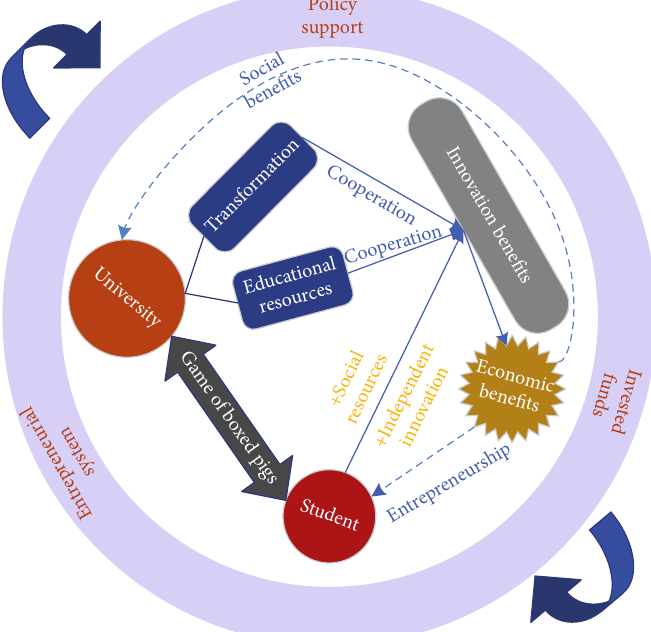
Figure 3: The equilibrium of strictly dominant strategies between government, universities and students based on the game theory.